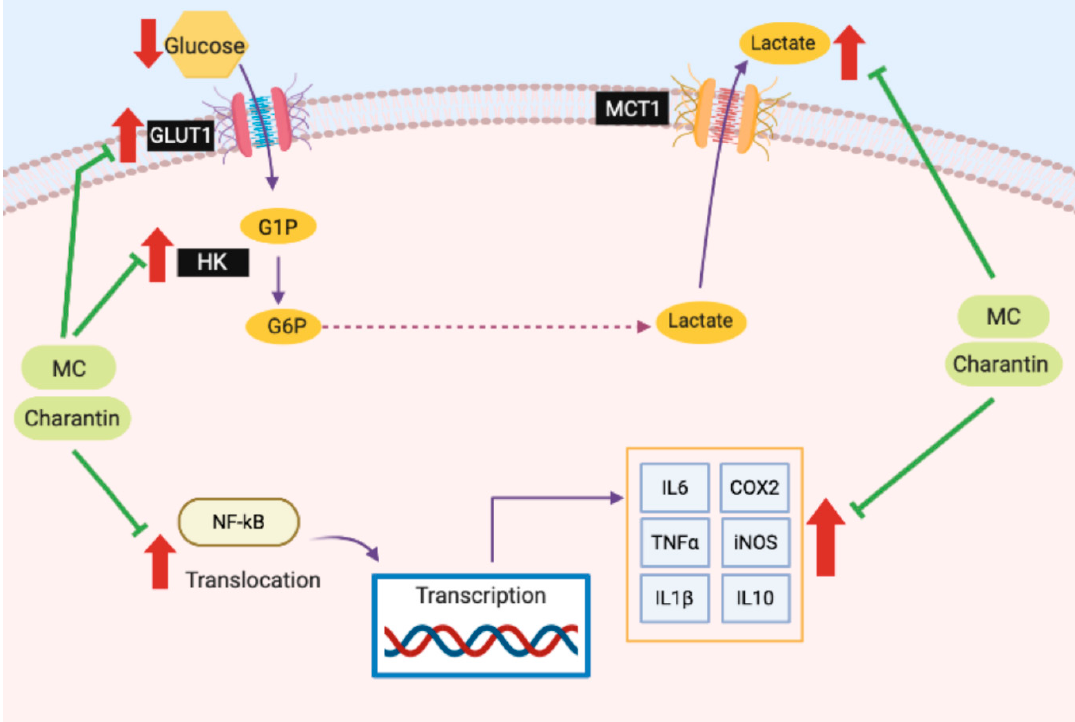
Figure 7. MC suppresses LPS-induced inflammation and perturbation in glucose metabolism, particularly on GLUT1 and HK gene expression, and extracellular concentrations of glucose and lactate. The red arrows show the upregulation of mRNA expression of the selected genes and changes in concentration of metabolites induced by LPS treatment.